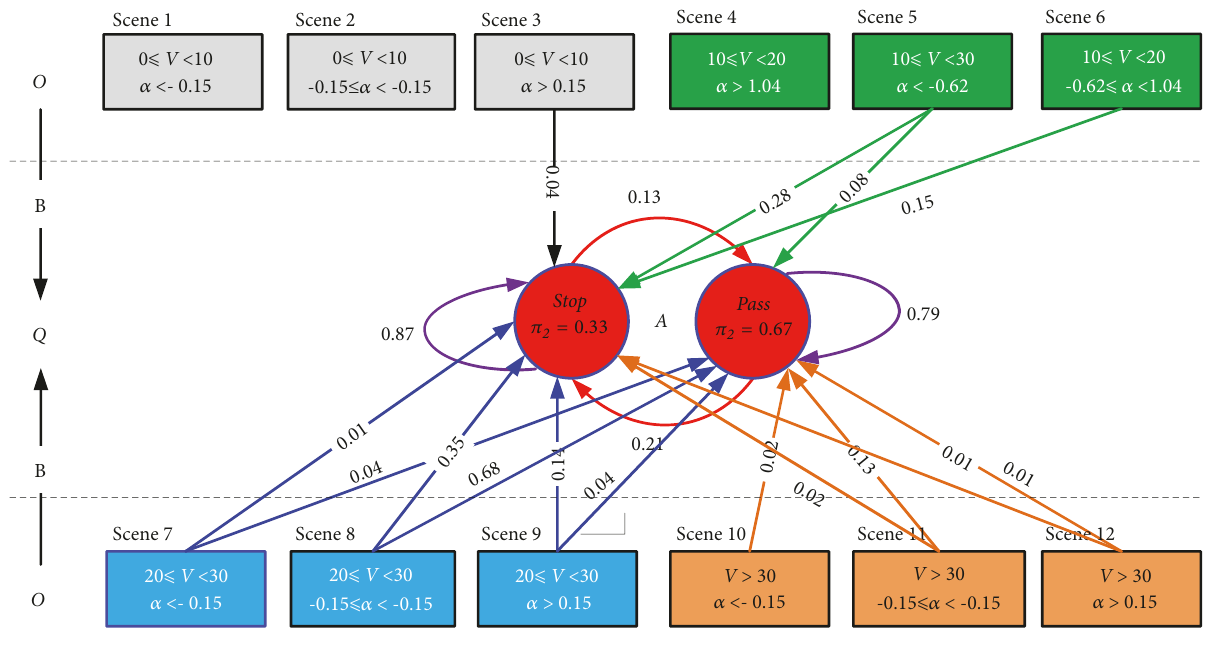
Figure 3: Training results for e-bike behavior. Table 2: Variables in the equation.